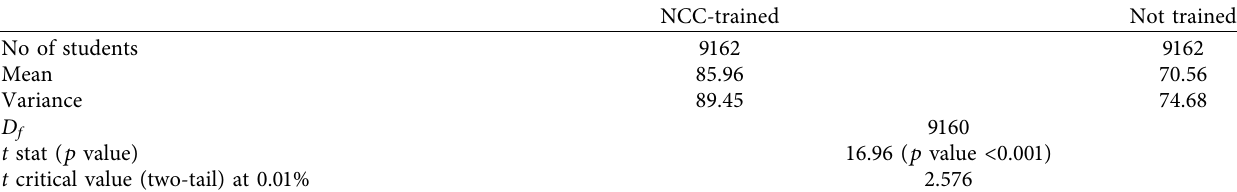
Table 1: Results of personality development qualities among NCC-trained and nontrained students (Madras Group).